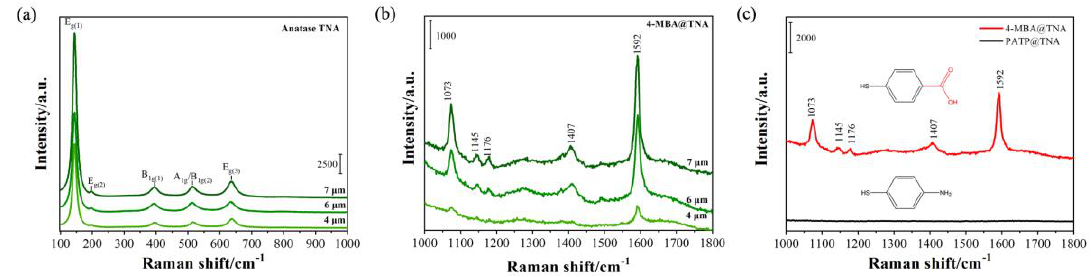
Figure 6. ( a ) In situ Raman spectra of TNA with different tube lengths; ( b ) surface-enhanced Raman scattering spectra (SERS) of 4-mercaptobenzoic acid (4-MBA)-modified TNA with different lengths; ( c ) Raman spectra of 4-MBA- and 4-aminothiophenol (PATP)-modified TNAs. The wavelength of excitation is 532 nm.